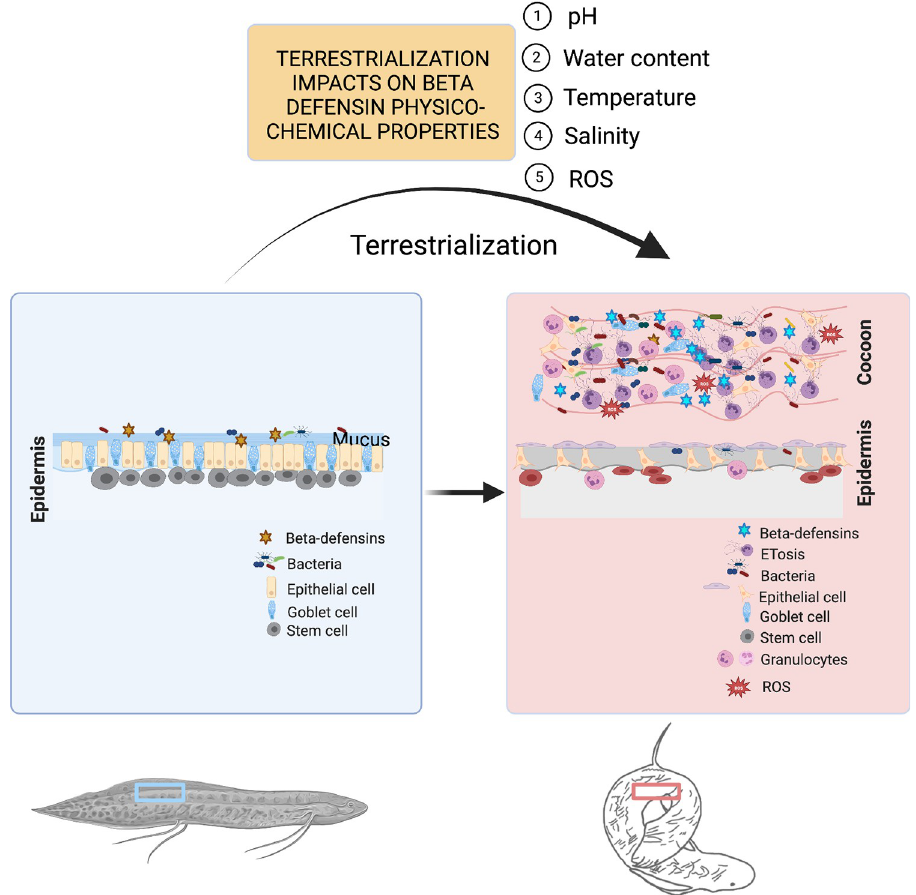
Fig 1. Schematic diagram with the changes that occur in the African lungfish skin upon terrestrialization and the hypothetical environmental factors that may impact AMP structure and function. This figure was made in